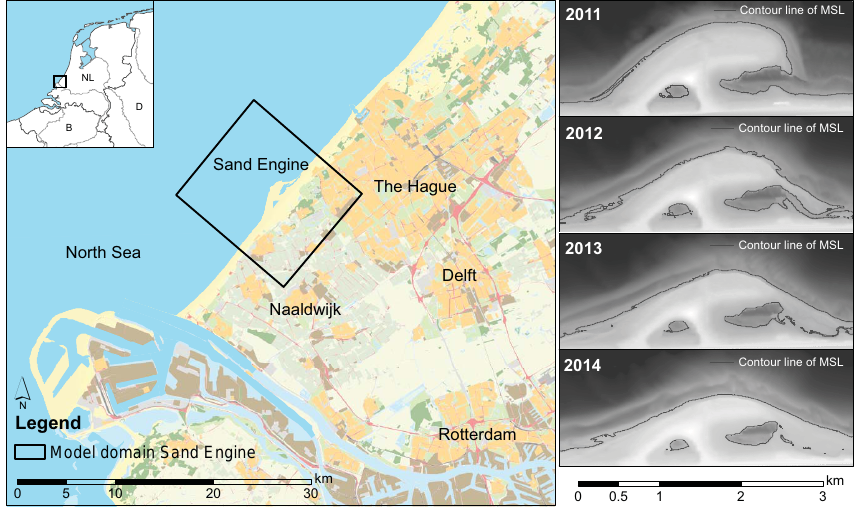
Figure 1. Situation of the Sand Engine and morphological development in